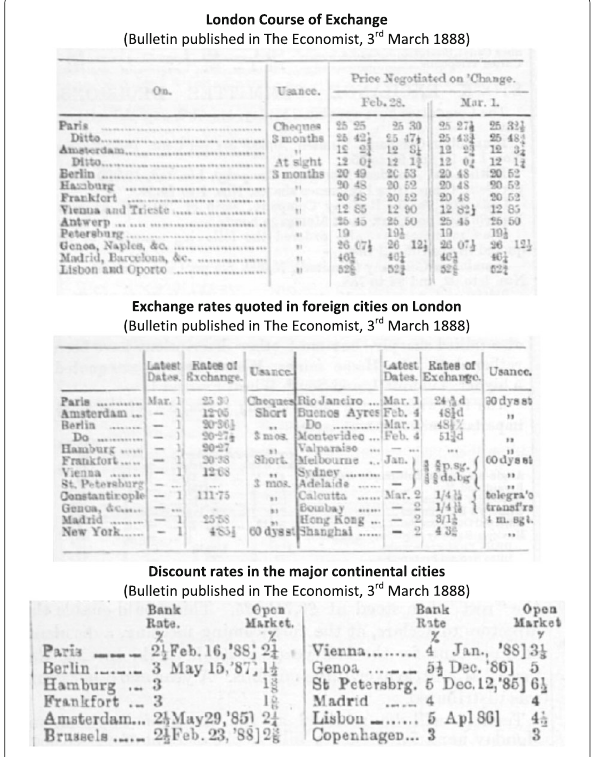
Fig. 1 Exchange and interest rates on 1 March 1888